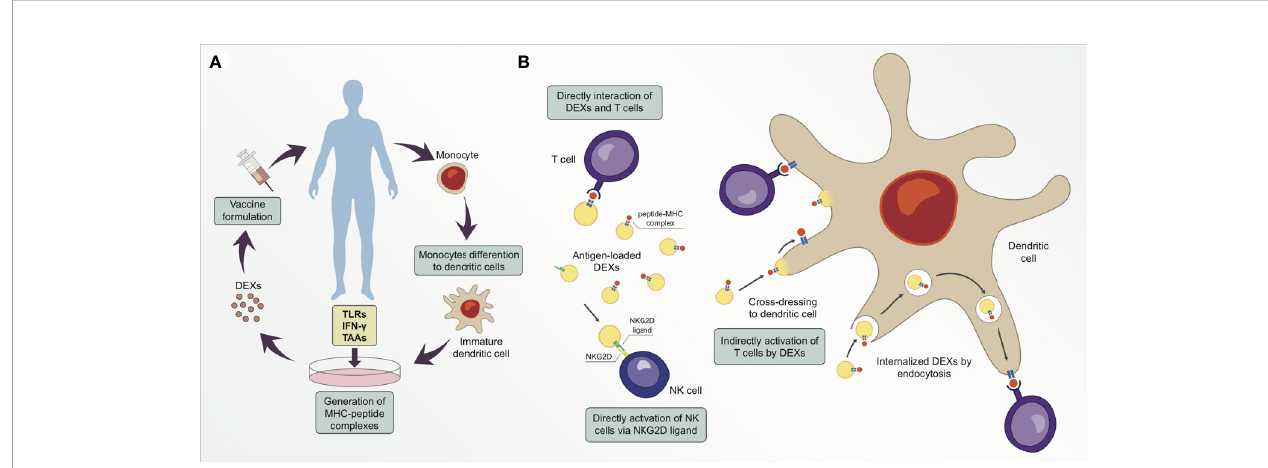
FIGURE 2 | Exosomes derived from dendritic cells (DEXs) are potential targets for cancer therapeutic strategy. (A) Simpli fi ed illustration of a personalized vaccine using DEXs. (B) DEXs can directly catalyze the transfer of peptide-MHC complexes from their membrane surface to T cell membrane surface (cross-dressing). Moreover, DEXs can stimulate T cell responses in an indirect manner via cross-dressing with dendritic cells or via exosome uptake and processing, following the peptide-MHC complex presentation to T cells. DEXs can also induce activation and proliferation of NK cells by establishing interaction of the NKG2D ligand on DEXs with NKG2D receptors on the NK cell